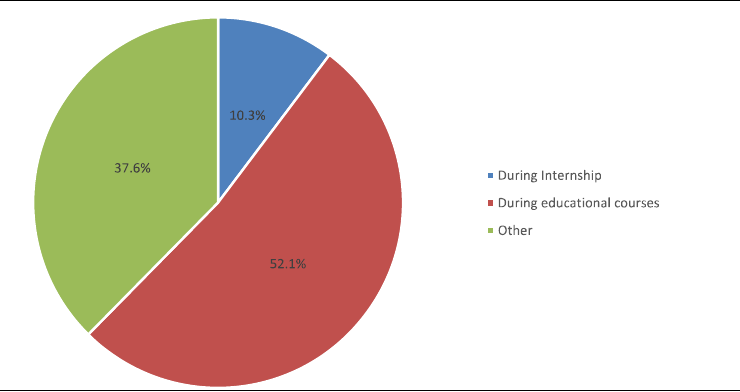
Figure 2. Respondents’ responses to the time they received training for MID.